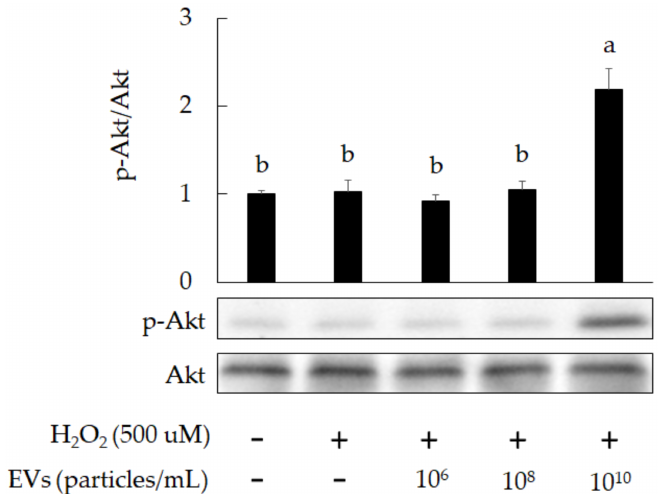
Figure 6. The promotion of Akt phosphorylation in H 2 O 2 -induced 3A-sub-E placental cells after treatment with L. crispatus -derived EVs (final concentration: 10 10 particles/mL) for 24 h. Data are expressed as mean ± SD (n = 3). Significant differences ( p < 0.05) are indicated by different letters (a,b)